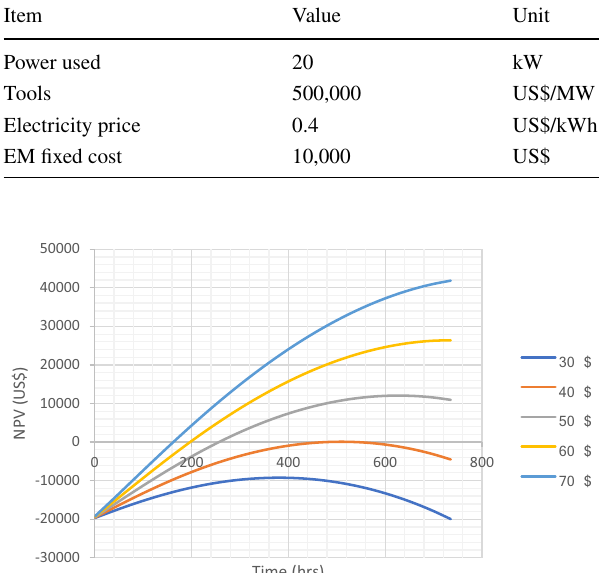
Fig. 8 Oil price sensitivity to project NPV